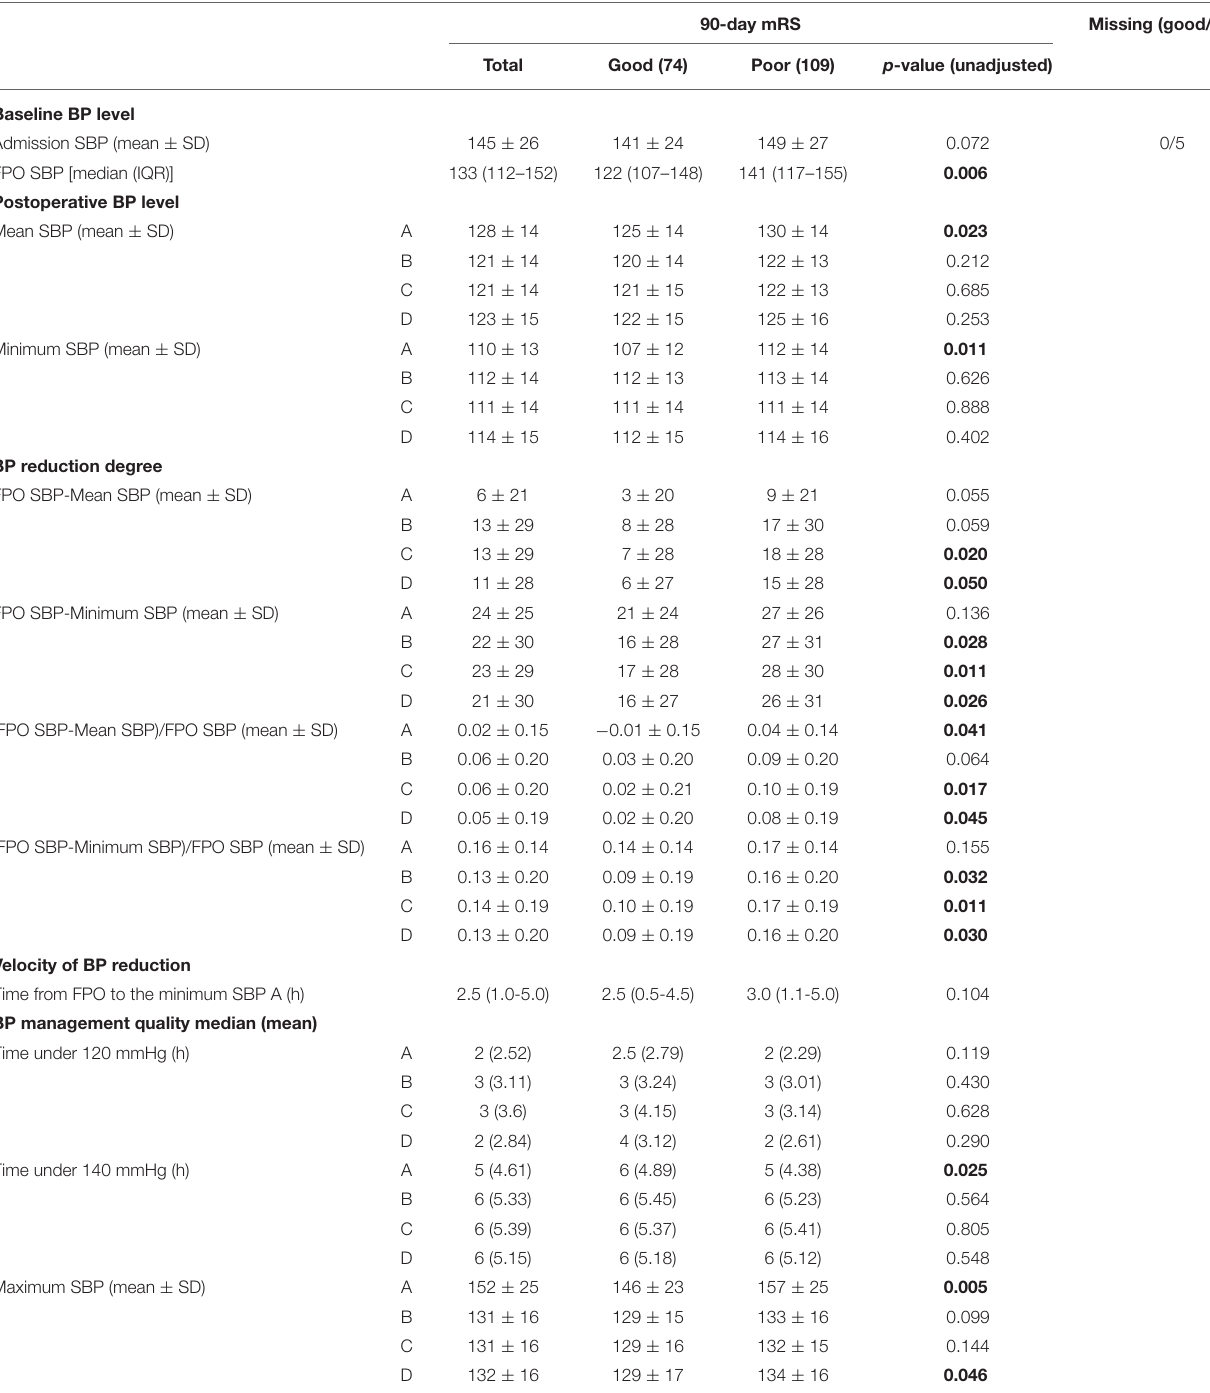
TABLE 2 | Associations between BP parameters and functional outcomes (mRS 0–2 vs.